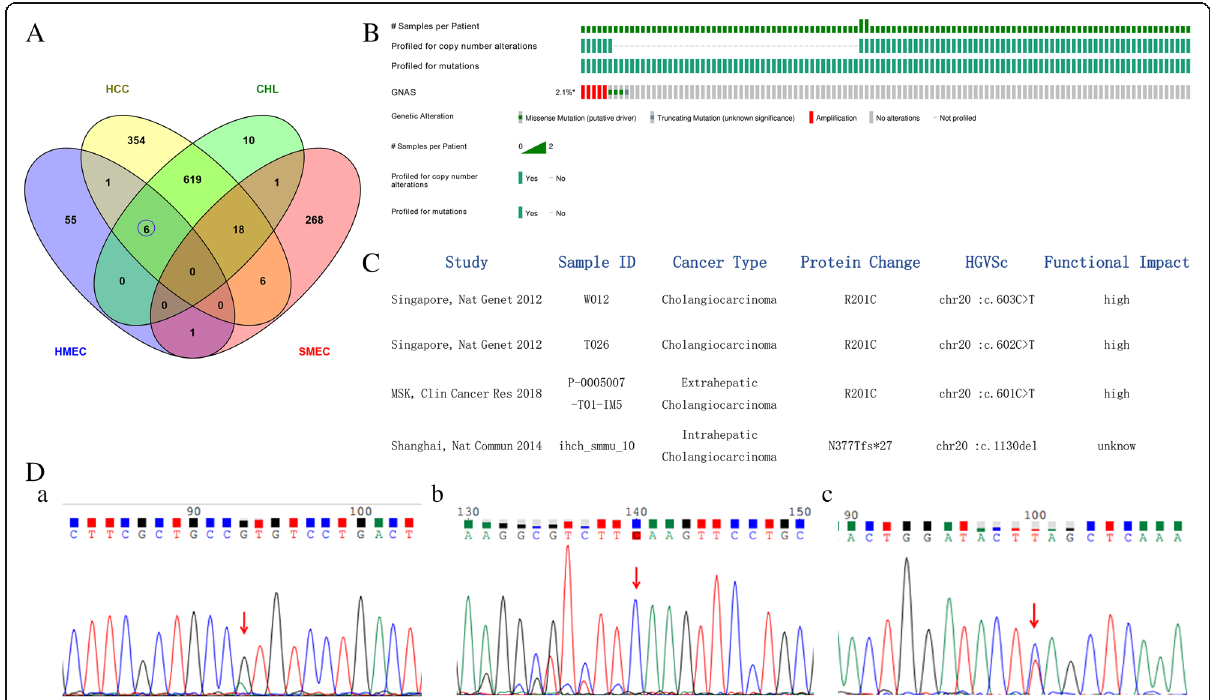
Fig. 5 Public data analysis and significant somatic mutation in the proband. (Mutation diagram circles are colored with respect to the corresponding mutation types. In the case of different mutation types at a single position, the color of the circle reflects the most frequent mutation type). A. Venn diagram: six SNVs (in STAT1 , TGFBR1 , NOTCH1 , KMT2C , ELF3 and GNAS genes) in the HMEC overlapped with primary liver tumors (HCC and CHL). Only a SNV in the CHD3 gene in HMEC overlapped with SMEC. B. Somatic GNAS gene mutation occurred in 2.1% (9/445) patients with primary hepatobiliary tumors in public databases. C. Three patients showed GNAS (p.R201H/C) missense mutation (putative driver).